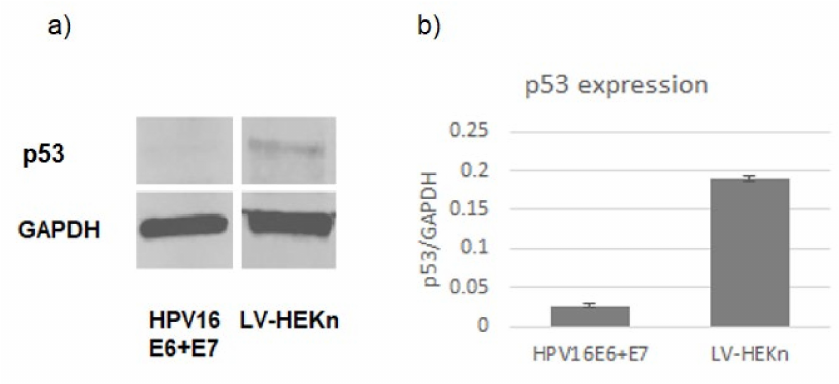
Figure 3. ( a ) Western blot experiments showed that p53 levels were reduced in cells transduced with HPV16 E6 and E7 lentiviruses compared to the control cells (LV-HEKn). ( b ) Bar charts indicate the average level of p53 normalized to GAPDH for three replicates of each cell